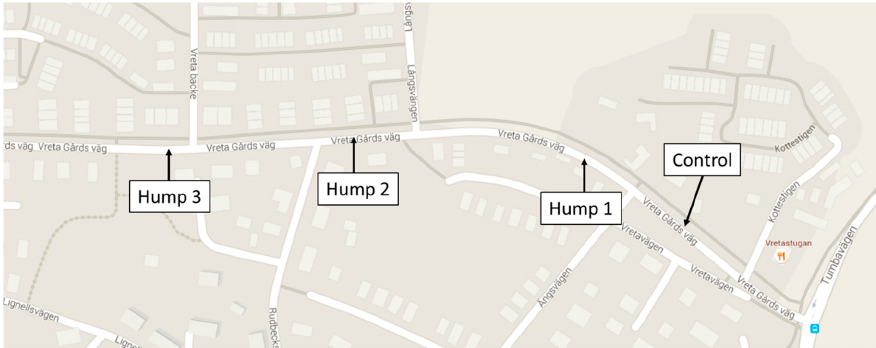
Figure 1. Map of Vreta Gårds väg, Stockholm, Sweden, showing the location of the three hump measurement sites and the control measurement site. Map data ©2016 Google.